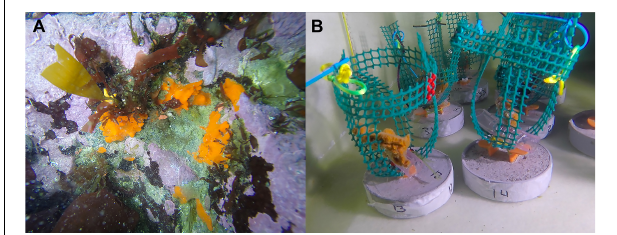
FIGURE 1 | The Antarctic sponge Isodictya kerguelenensis . (A) Photographed in situ at 10 m depth in Cape Kemp off Yelcho Research Station, Doumer Island, WAP (64 ◦ 51 (cid:48) S 63 ◦ 35 (cid:48) W) in January 2017. (B) Isodictya kerguelenensis individuals maintained under experimental conditions in holding tanks at Yelcho Research Station at Doumer Island,